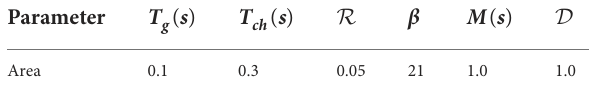
TABLE 3 MADUBs h 2 for fixed μ = 0 . 9 and various K P and K I .